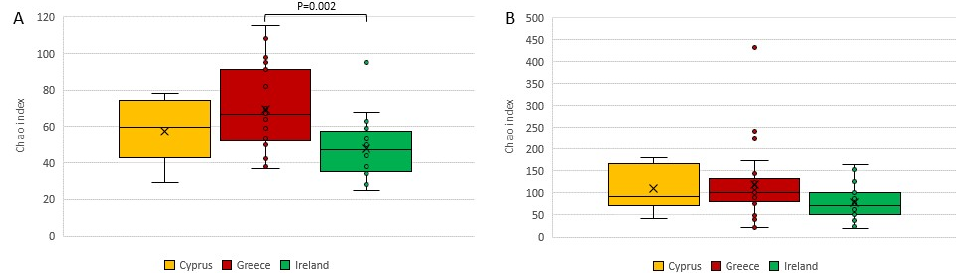
Figure 2. Comparison of ( A ) bacterial and ( B ) fungal alpha diversities of Cyprus, Greek, and Irish cheeses, based on the Chao1 index. Statistical analysis was performed using the Kruskal–Wallis test.